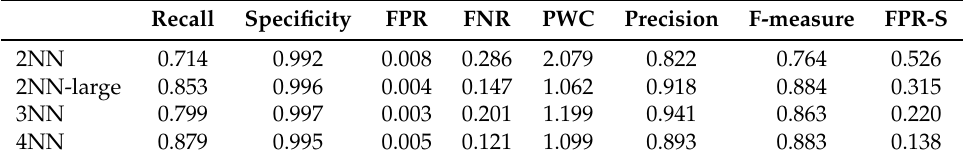
Table 4. Average detection accuracies on three sequences of the shadow category in the CD2014 dataset [7]. Networks use the sequences of a shadow category simultaneously. Thus, the dataset complexity increases.FPR, FPR-S, FNR, and PWC denote false positive rate, FPR in only shadows, false negative rate, and percentage of wrong classifications,